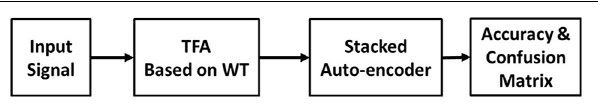
FIGURE 2 | Five phases of TUG. FIGURE 3 | Flowchart for DNN-based